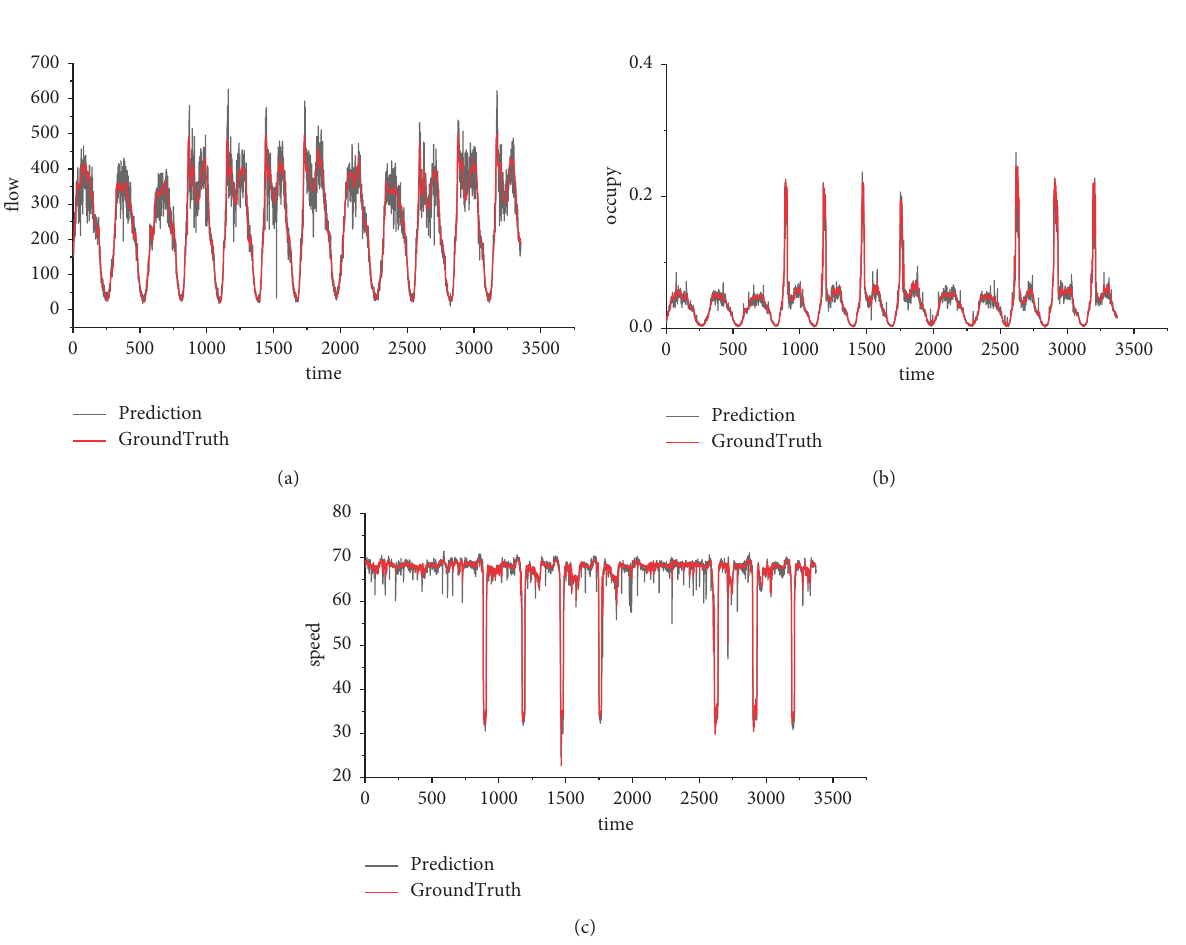
Figure 14: Comparison of the real values and predicted values for the three features on the PEMSD4 dataset. (a) Comparison of traffic flow. (b) Comparison of traffic occupy. (c) Comparison of traffic